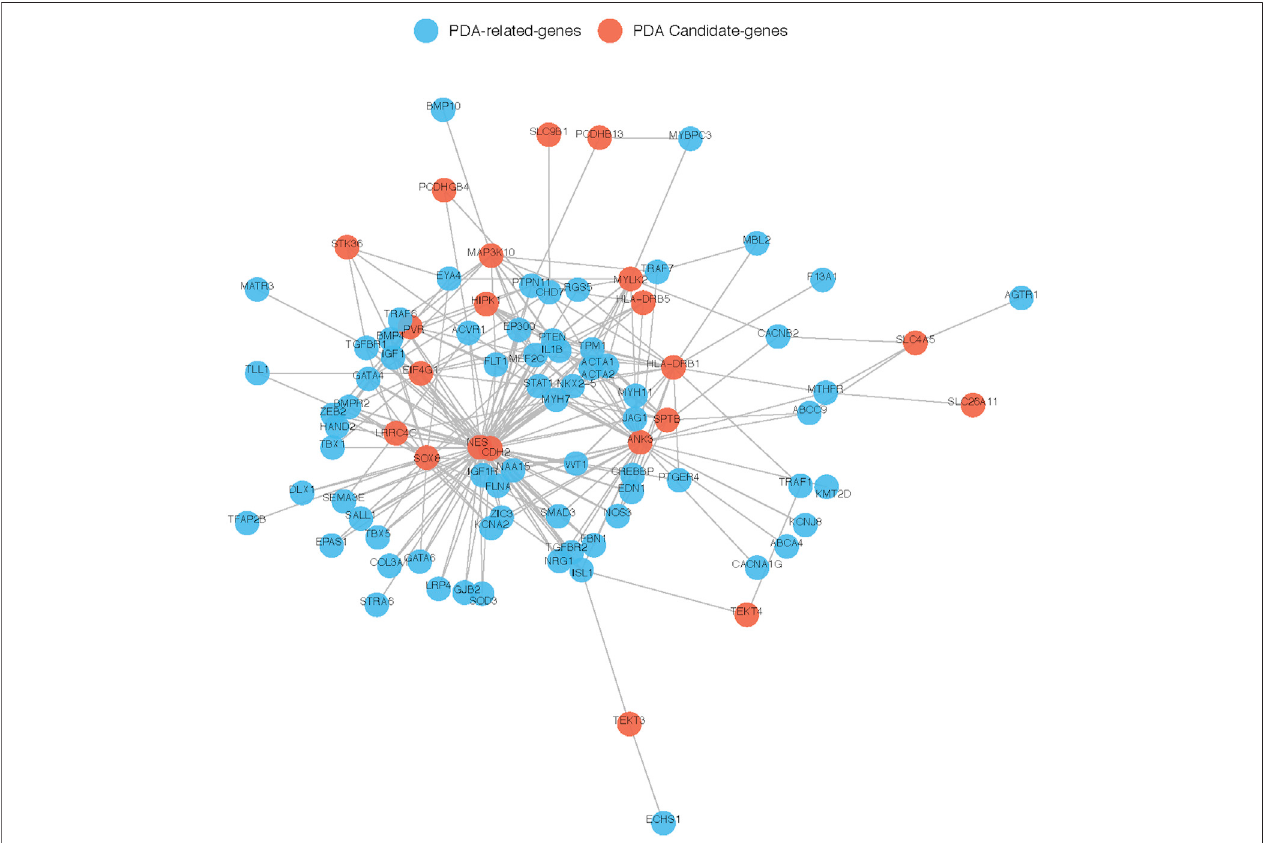
FIGURE 8 | Interaction between our candidate genes and known PDA-related genes. PPI network was generated by Cytoscape software and Our candidate pathogenic genes and the known CHD-related genes were uploaded in STRING database. Each node represents one gene, and each edge represents the protein- protein interaction collected from